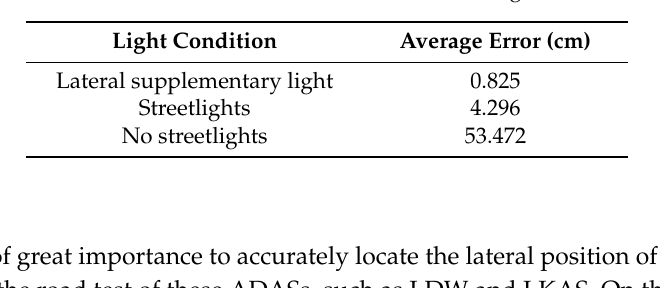
Table 4. Detection results of models at